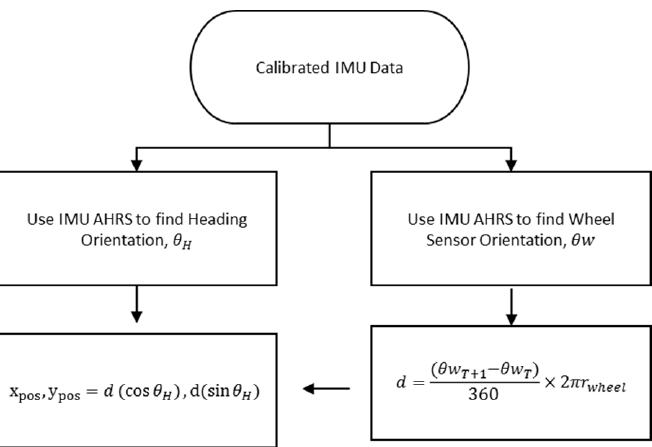
Figure 1. Overview of the Algorithmic implementation. The algorithm requires inertial measurement unit (IMU) data from a chair sensor and one or more wheel sensors, and the radius of the wheel ( r wheel ) as inputs. The algorithm outputs distance ( d ), heading orientation from chair sensor ( θ H ) , orientation from wheel sensor ( θ W ) , and the positional coordinates X pos ,y pos